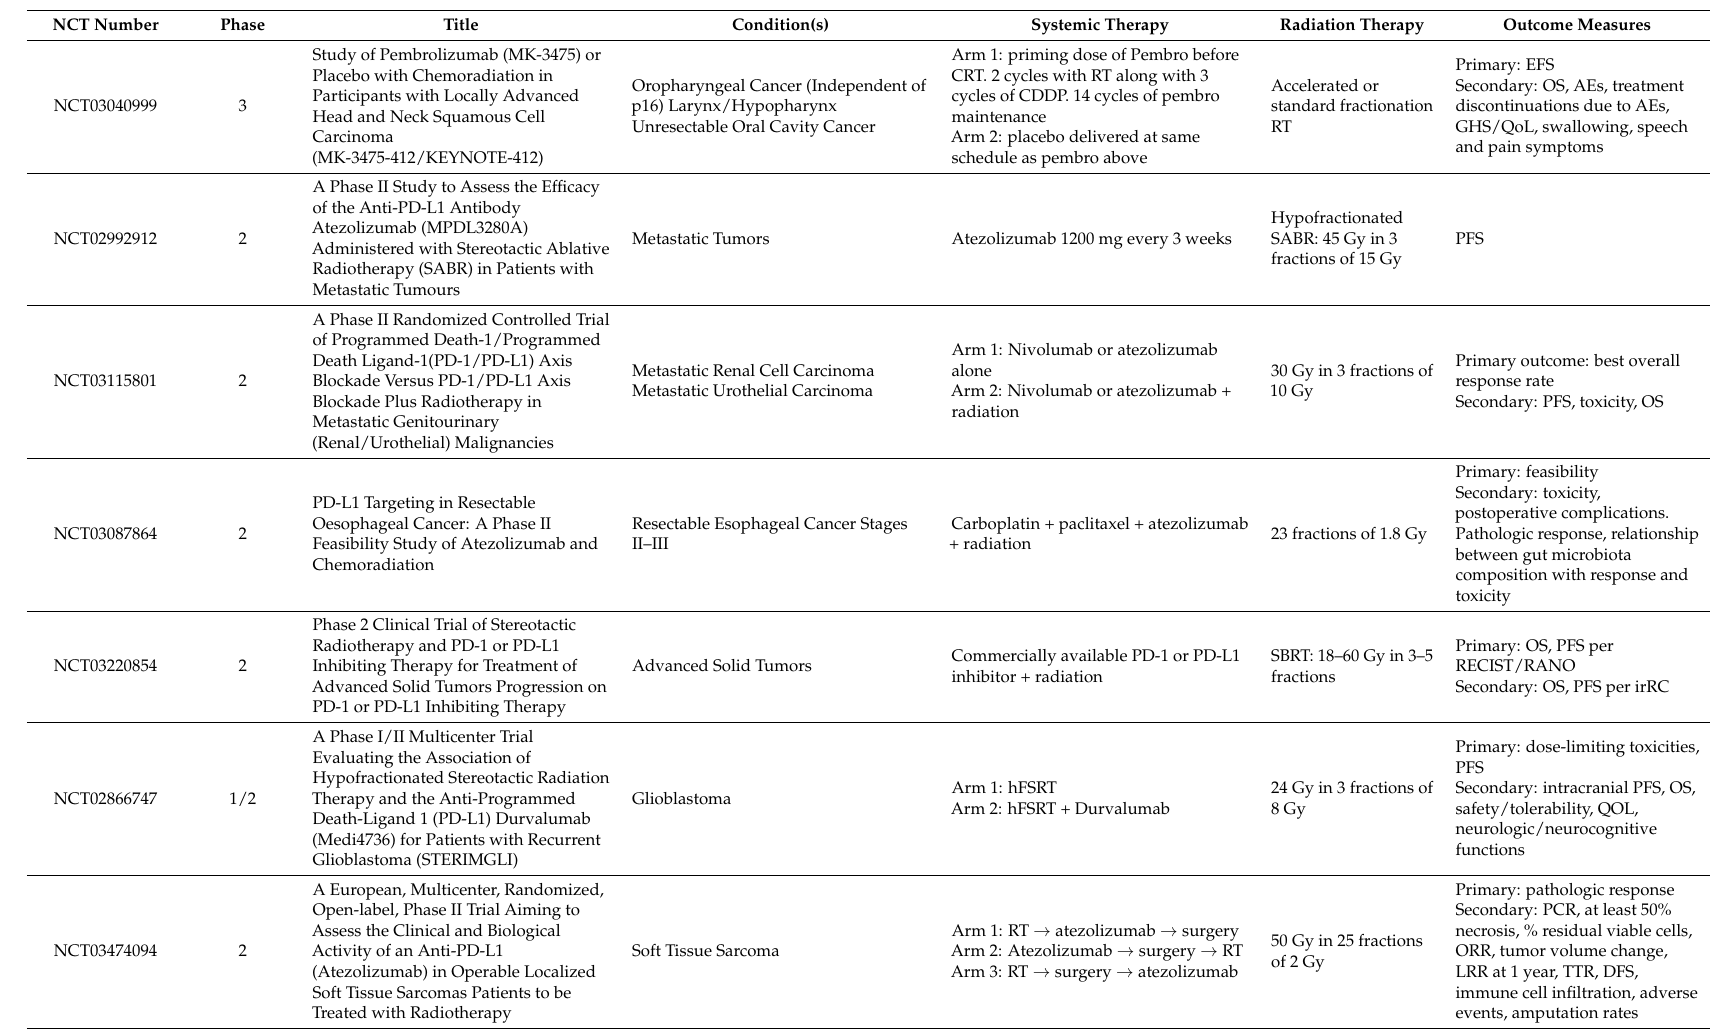
Table 2. Active Clinical Trials Combining PD-1/PD-L1 Blockade with